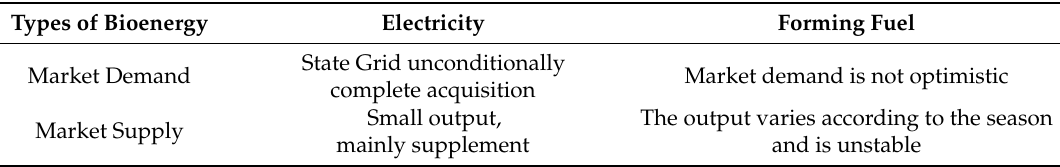
Table 4. Condition of market demand of